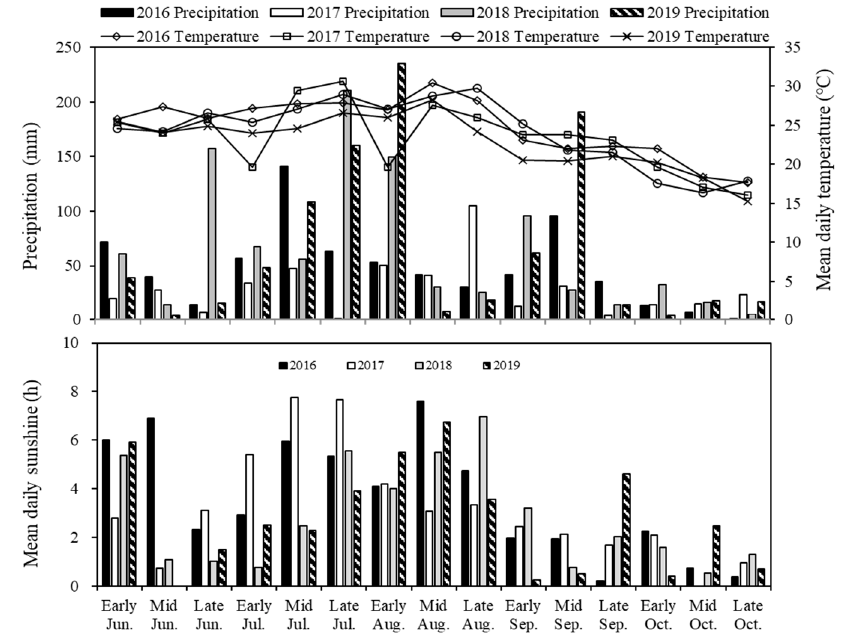
Figure 9. The 10-day precipitation, mean daily temperature, and sunshine hours during soybean growth season in 2016, 2017, 2018, and 2019.